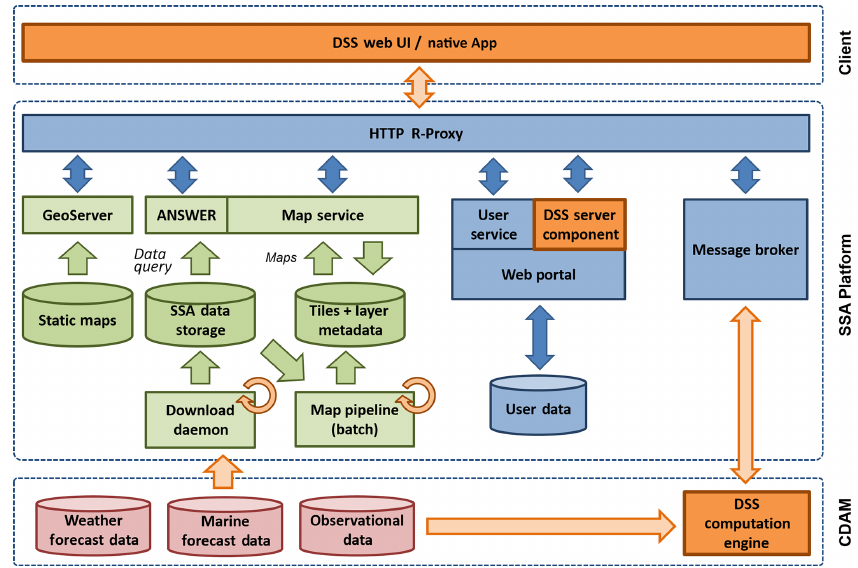
Figure 1. SSA platform architecture (color key: blue for front-end components, green for map components, red for external modules or externally produced data, brown/orange for the DSS-specific components and